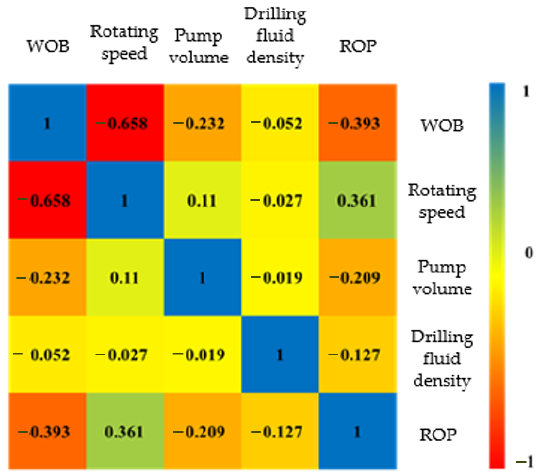
Figure 10. Section 3 of Liushagang Formation.